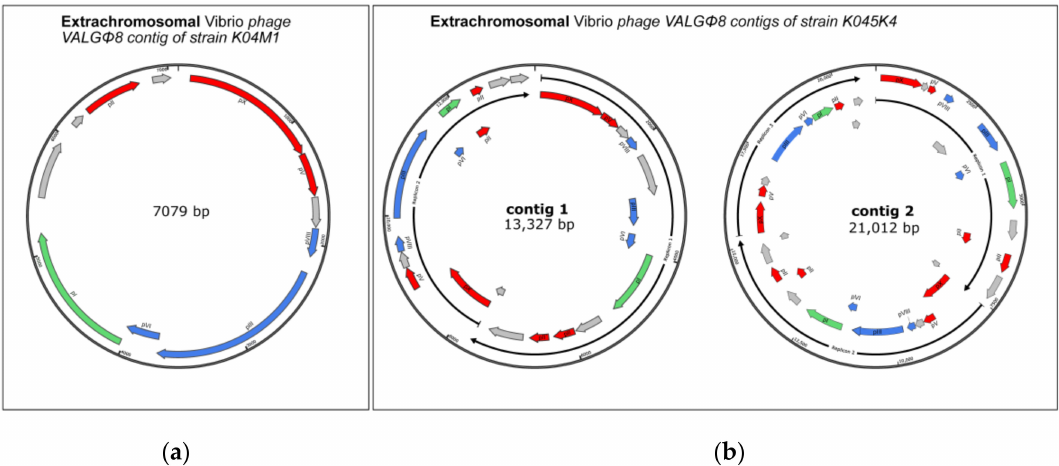
Figure 4. Extra-chromosomal contigs of Vibrio phage VALG Φ 8 sequenced from ( a ) strain K04M1 and ( b ) strain K05K4 with the 2-replicon containing contig (left) and the 3-replicon containing contig (right). ORF-coding and protein names as in Figure